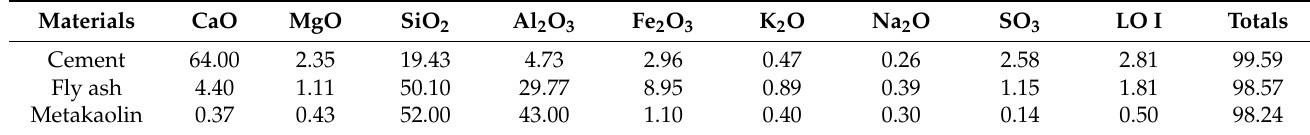
Table 1. Chemical composition of cementitious materials (wt%).